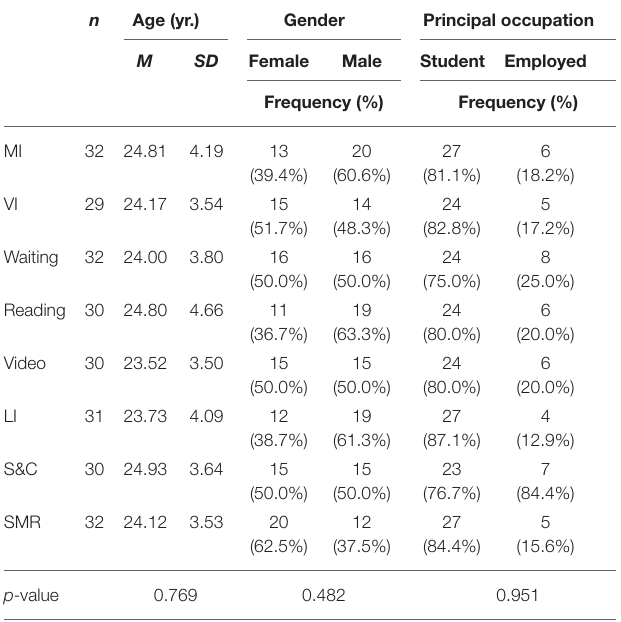
TABLE 2 | Sample’s demographic data separated into treatment groups.